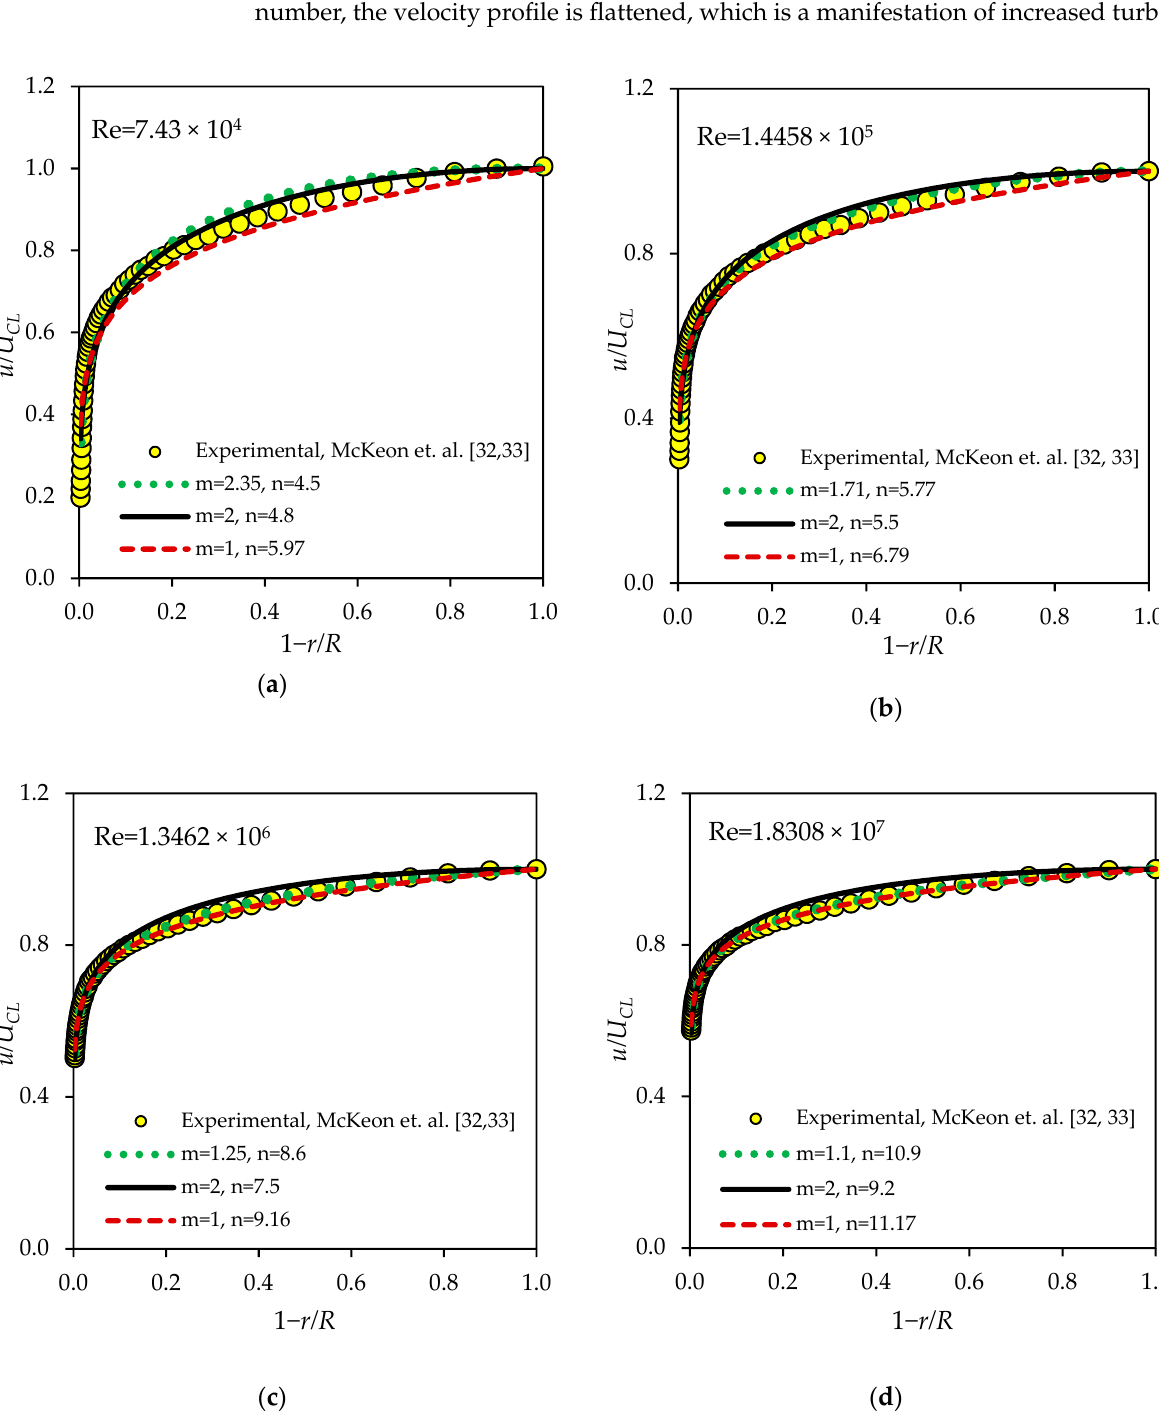
Figure 8. Comparisons between the measured velocity profiles and those calculated based on the optimization of one or two of the parameters (i.e., m and n ) at different Re . ( a ) Re = 7.43 × 10 4 , ( b ) Re = 1.4458 × 10 5 , ( c ) Re = 1.3462 × 10 6 , and ( d ) Re = 1.831 × 10 7